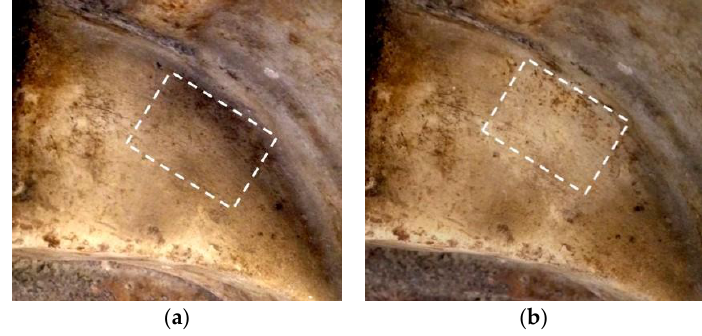
Figure 5. ( a ) Marble sculpture before; ( b ) Marble sculpture after HNT-microemulsion treatment.